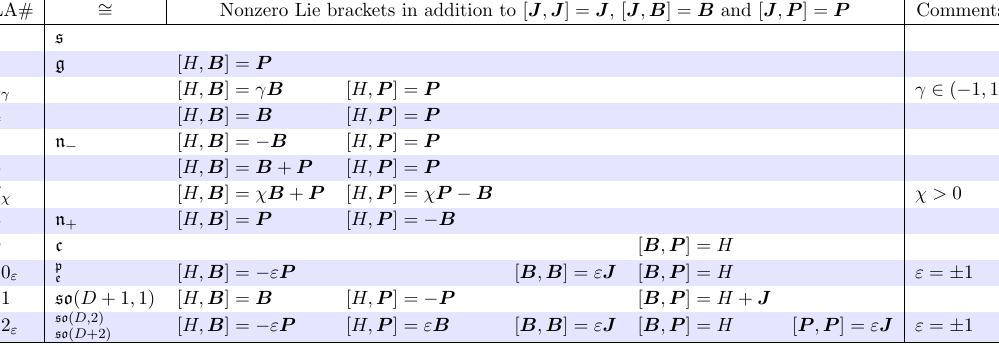
Table 4 . Generic kinematical Lie algebras for D (cid:21)